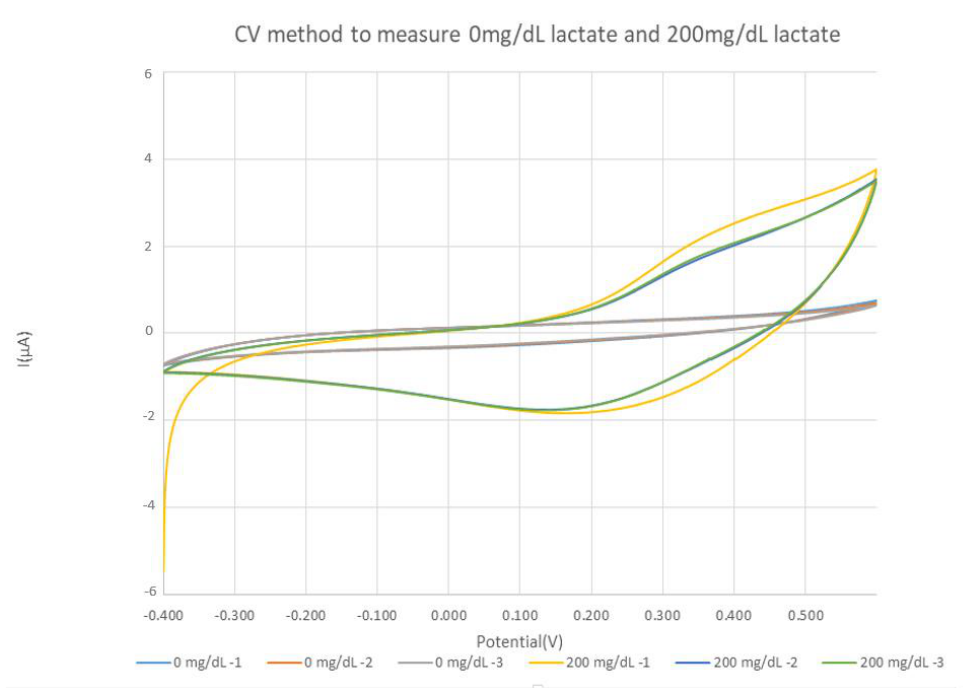
Figure 2. The lactic acid CV map (measured using a PalmSens potentiostat) with a lactic acid con- centration of 0 mg/dL and 200 mg/dL. concentration of 0 mg/dL and 200